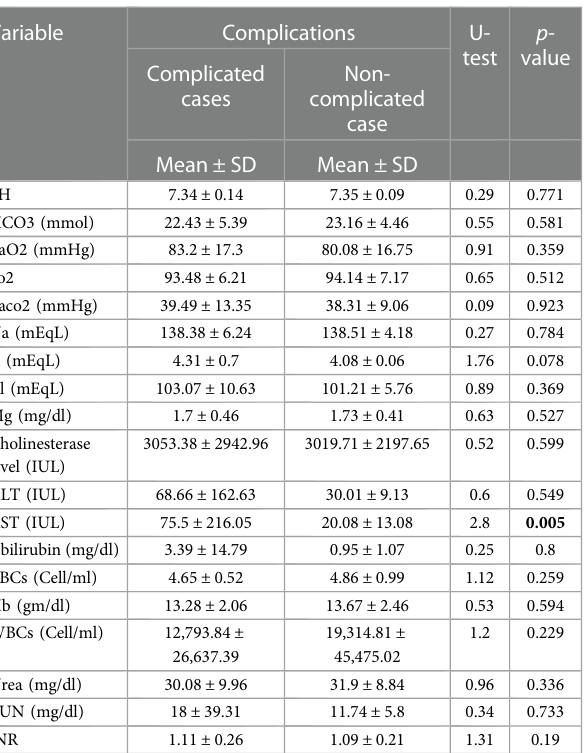
TABLE 7 Relationship between complicated cases and laboratory results